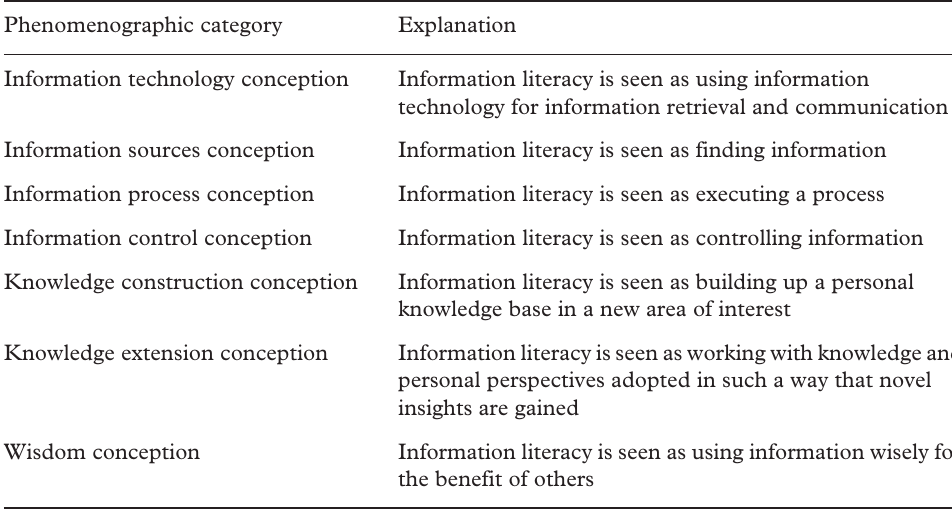
Table 1. Christine Bruce’s seven faces of information